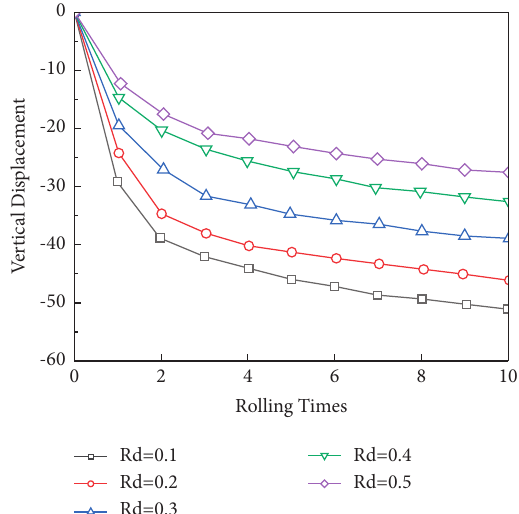
Figure 21: Displacement components of fillings in the vibration rolling process: vertical